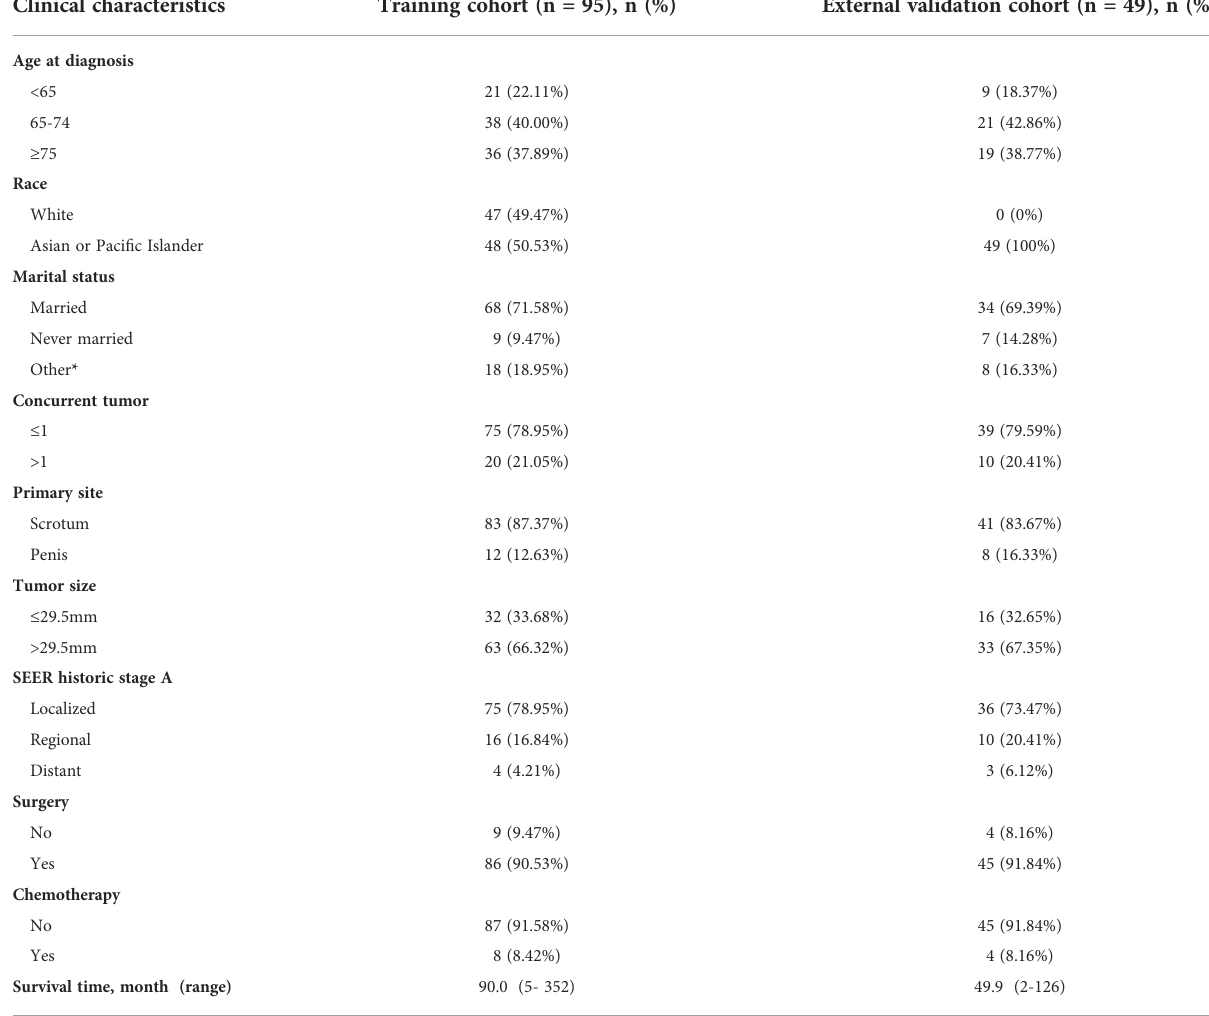
TABLE 1 The clinical characteristics of the training cohort and the external validation cohort. Clinical